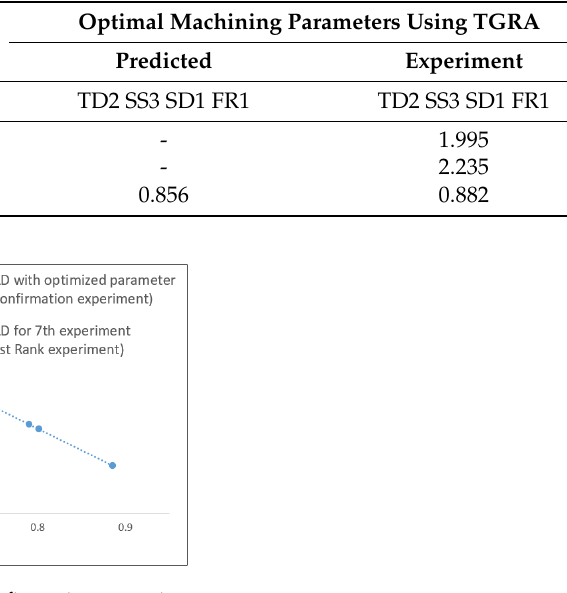
Table 9. Results of ISF in confirmation test.